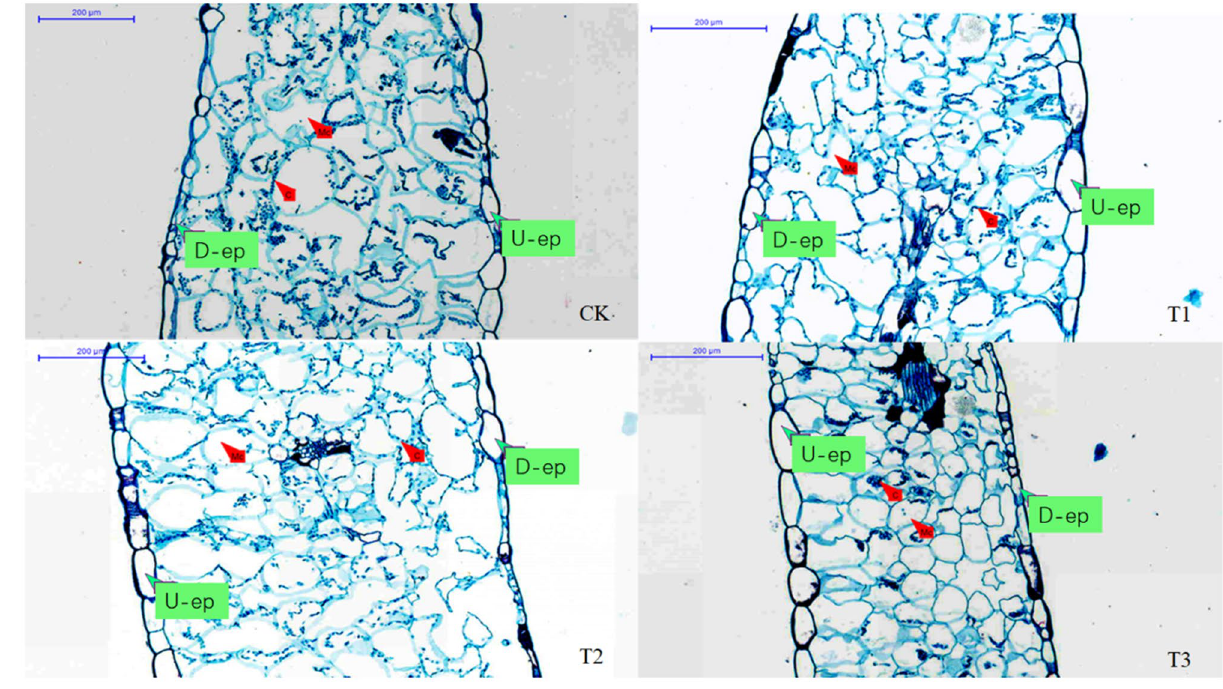
Figure 2. Changes in the anatomical structure of Phedimus aizoon L. leaves on the 30th day of drought stress. Notes : U-ep, upper epidermis; D-ep, lower epidermis; Mc, mesophyll cell; C, chloroplast.